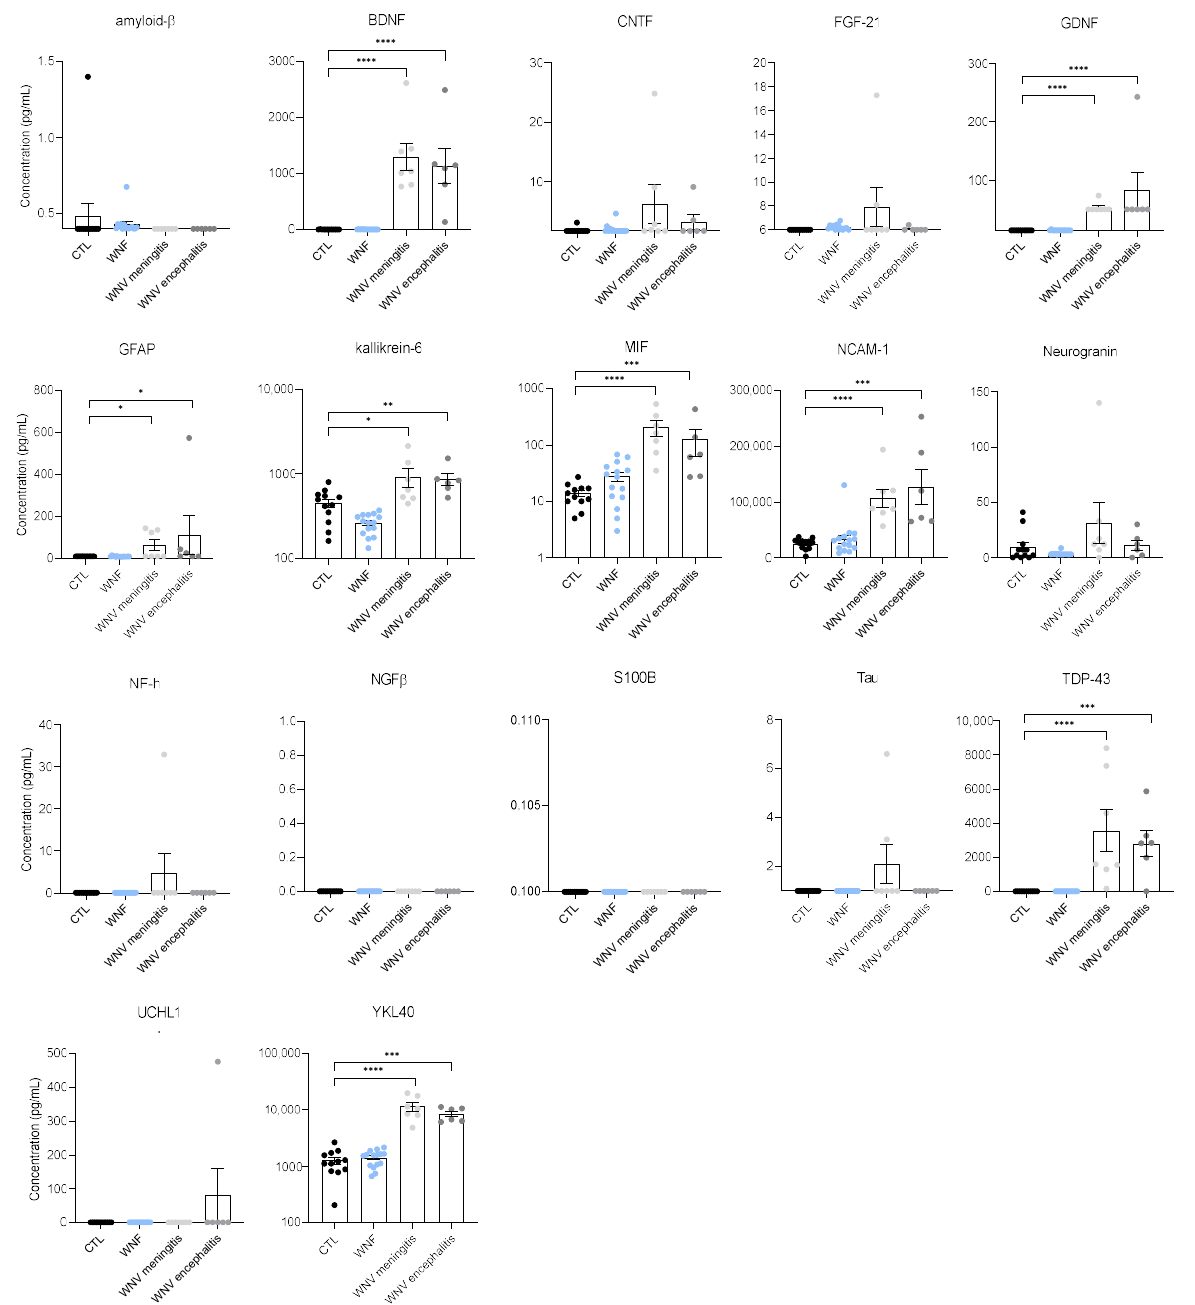
Figure 4. Sera of WNND patients display markers of neuro-inflammation and neuronal injuries. Plasma concentration in pg/mL of different pro-inflammatory markers of non-infected CTL (black), WNF (blue), WNV-meningitis (light grey) and WNV-encephalitis (dark grey) humans, measured by multiplex bead-based ELISA. Bars show means ± SEM (* p < 0.05, ** p < 0.01, *** p < 0.001, **** p < 0.0001).